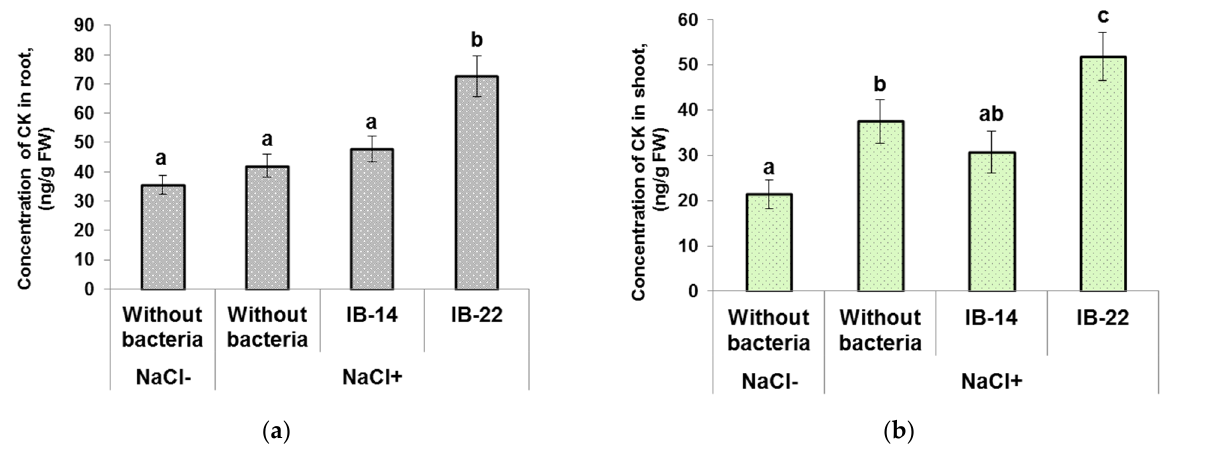
Figure 2. Effect of 100mM NaCl and bacterial treatment with Pseudomonas mandelii IB-Ki14 (IB-14) and Bacillus subtilis IB-22 (IB-22) on cytokinin concentration in the roots ( a ) and in the shoots ( b ) of 6-day-old wheat plants. Data are means ± SE. Significantly different means are labeled with different letters at p ≤ 0.05, n = 6 (ANOVA followed by Duncan’s test).